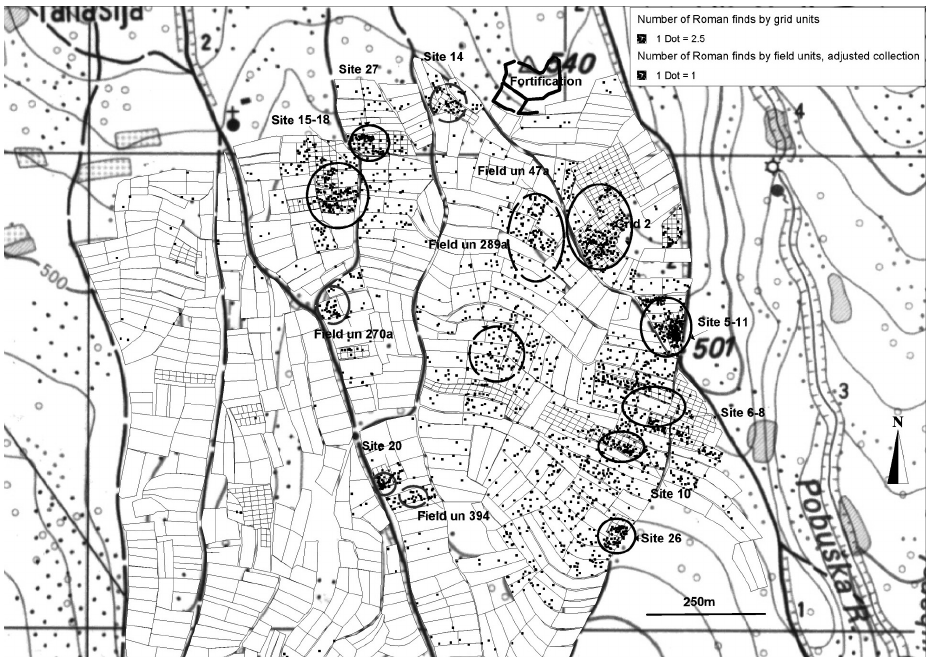
Figure 5: An interpretative map of the survey results near